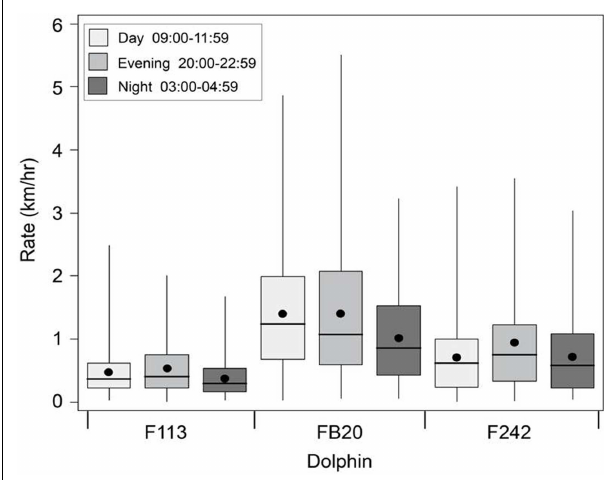
FIGURE 12 | Boxplots of travel rates for Sarasota Bay bottlenose dolphins tagged with satellite-linked transmitters during 2012 . Time-of-day categories (local) were defined by the tags’ pre-programed transmission windows (duty cycle). Boxes show interquartile ranges, dots, and lines respectively denote means and medians, and whiskers span minimum and maximum